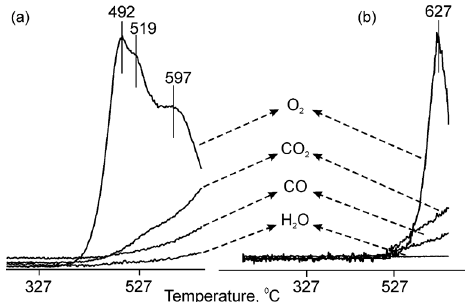
Figure 9. TPD spectra of oxygen taken from the surface of ( a ) the unpromoted Ag foil (Po 2 = 400 Pa at 400 °C for 30 min) and ( b ) P-containing Ag foil (Po 2 = 400 Pa at 400 °C for 10 h). Reprinted with permission from reference [84]. Copyright 2008 Elsevier.